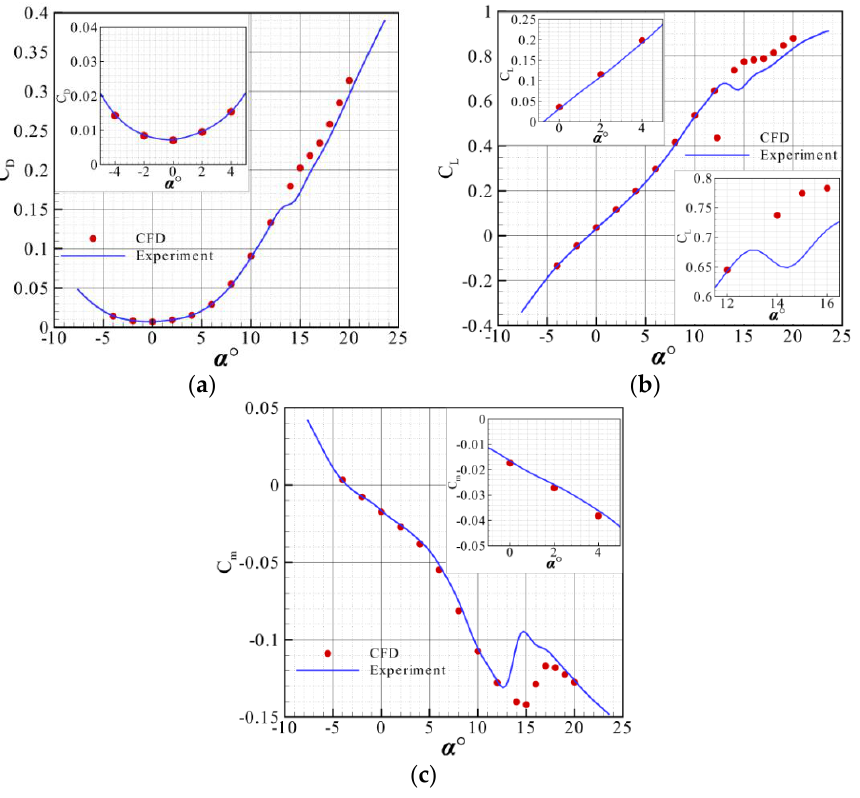
Figure 4. Comparison of test data and simulation results for aerodynamic characteristics ( Tu = 0.7%, M = 0.9, α = 2°, Re = 10 × 10 6 ). ( a ) Drag coefficient; ( b ) lift coefficient; ( c ) pitching moment coefficient.